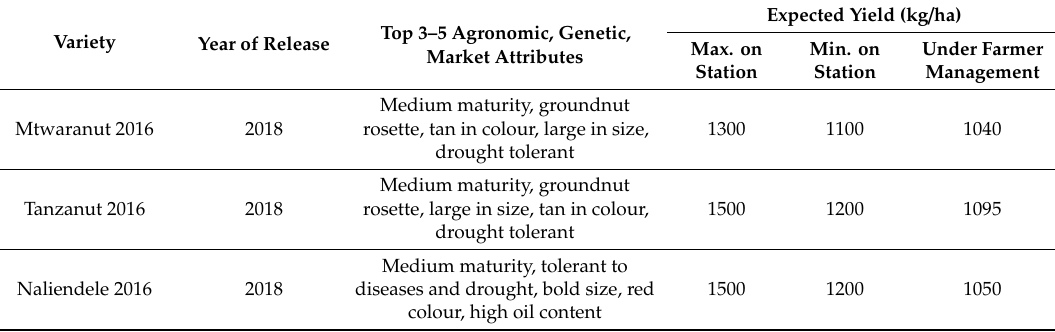
Table 5. Improved varieties released and their attributes and yield potential in kg / ha